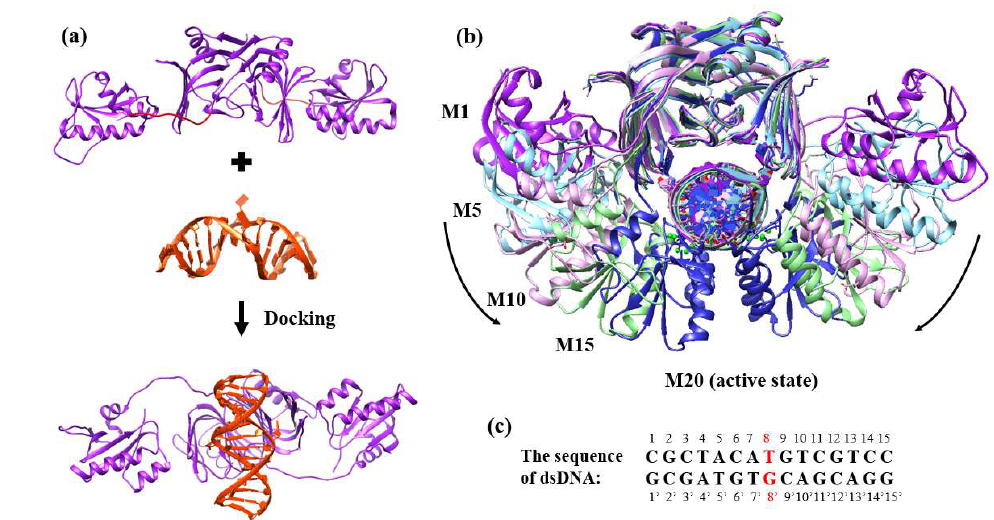
Figure 9. ( a ) The docking process of apo EndoMS/NucS with the mismatched dsDNA. The docking was based on the dsDNA-bound crystal structure (PDB: 5GKE). The missing loops of EndoMS/NucS, modeled by MODELLER, are colored in red. ( b ) Twenty models from the open state (M1) to the closed state (M20) were modeled by the Chimera software. Detailed information for all the models (M1–M20) can be found in Table S3. ( c ) The mismatched dsDNA sequence that was used in this study. The mismatched base pair (T/G) is colored in